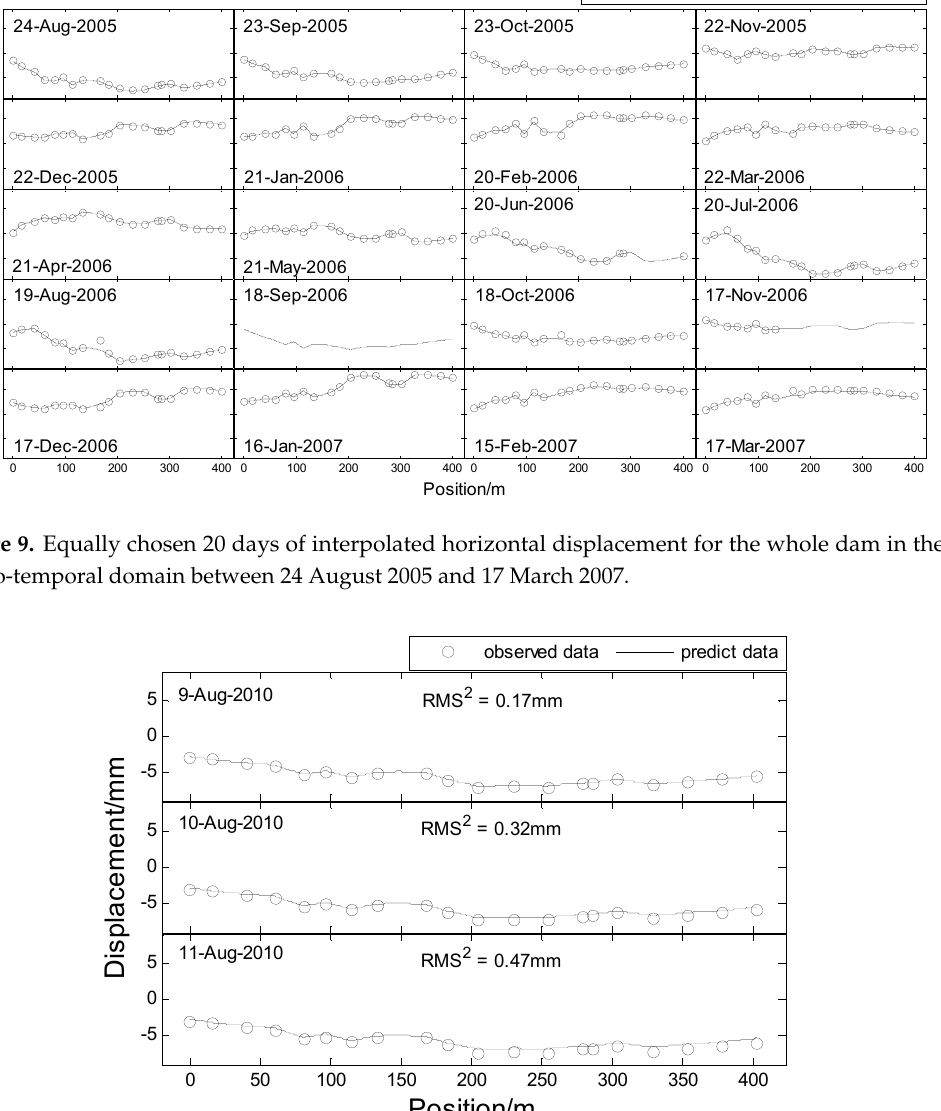
Figure 10. Three days of horizontal displacement prediction for the whole dam.